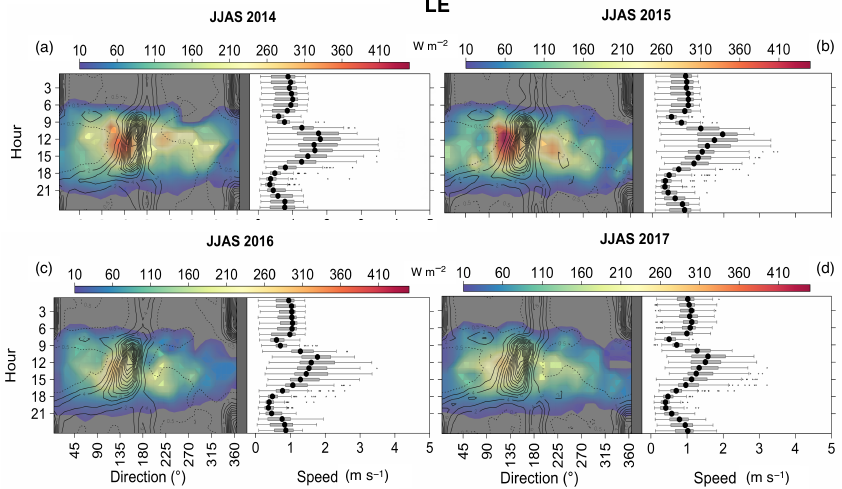
Figure 2. Mean latent heat flux ( LE ) and wind frequency contour maps as a function of wind direction and hours of the day (left coloured panels) and wind speed mean diurnal cycle (right white panels) The left coloured panels show the wind direction contour lines (for both daytime and nighttime) and the latent heat flux colour map for the four average June-to-September periods, between 6:00 and 20:00, when most of the evapotranspiration occurs. The right white panels show the mean wind speed along the day, together with the standard deviation of values for each half-hour. Asterisks indicate outliers (i.e. values outside 1.5 times the interquartile range or IQR, above the upper quartile or below the lower quartile). Grey areas indicate no LE data (nighttime was excluded). Plot made using Metvurst R package [81] . ( a ) 2014. ( b ) 2015. ( c ) 2016. ( d )